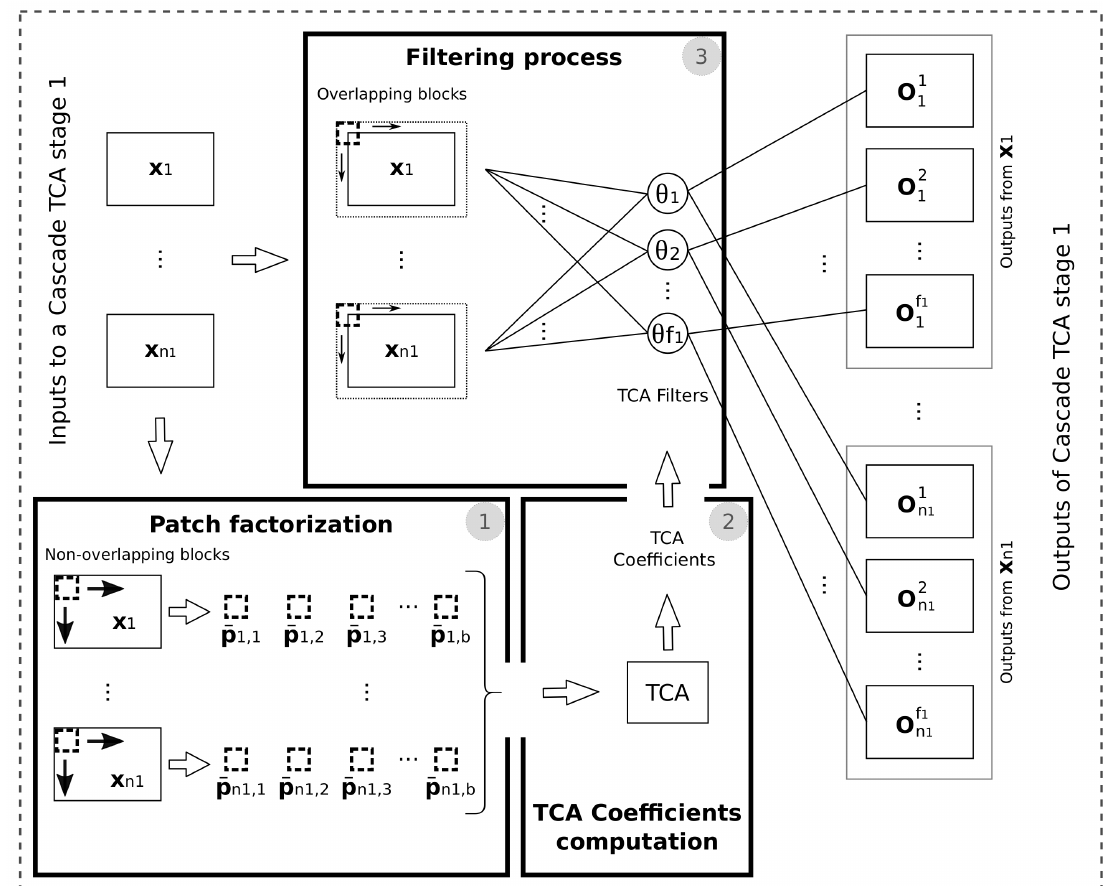
Figure 5. Details of the cascade TCA stage